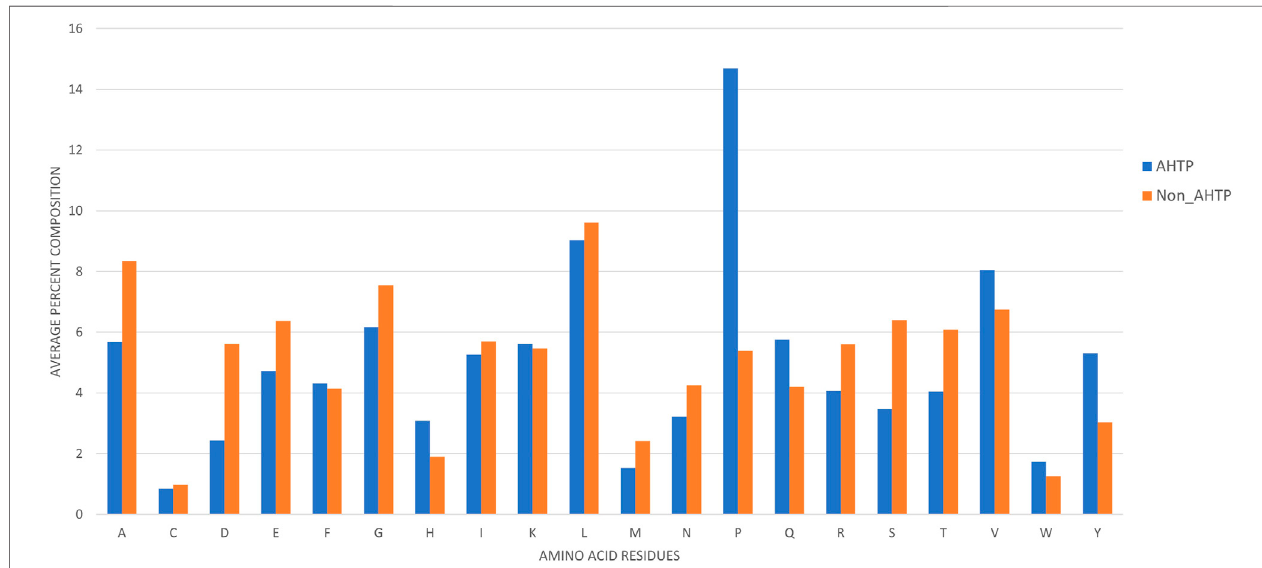
FIGURE 2 | Percent average composition of amino acid residues present in the positive and negative